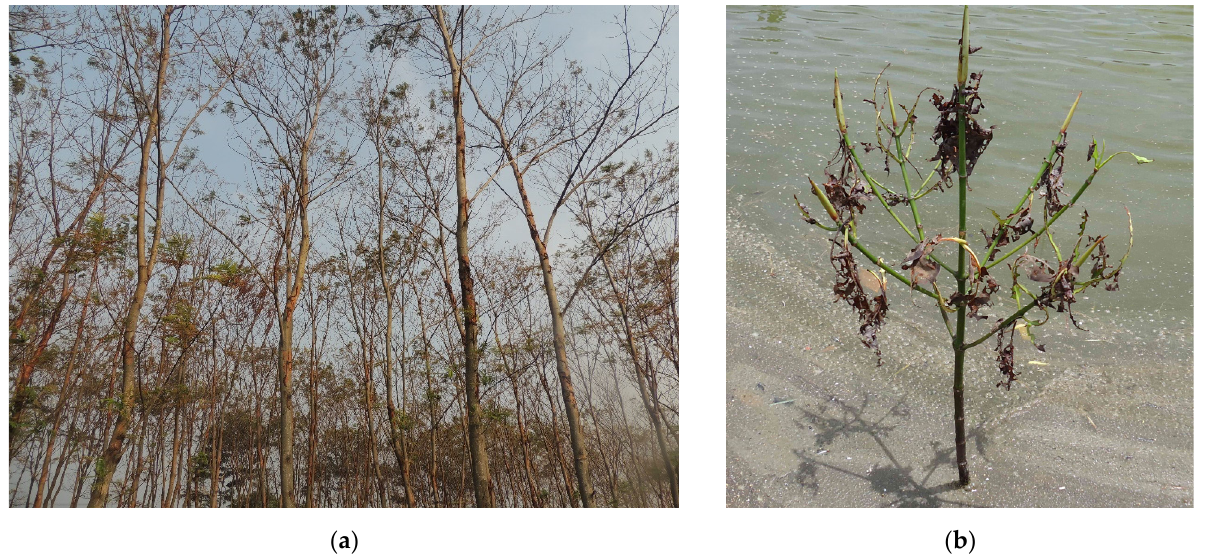
Figure 4. Infestation of bagworms in a forest. ( a ) Condition of F. moluccana stands infested by Pteroma plagiophleps in an F. moluccana plantation in Central Java. Almost all trees were severely defoliated, and some of them were dead. ( b ) Mangrove tree infested by Pagodiella sp. in Sumatra, with severe defoliation.